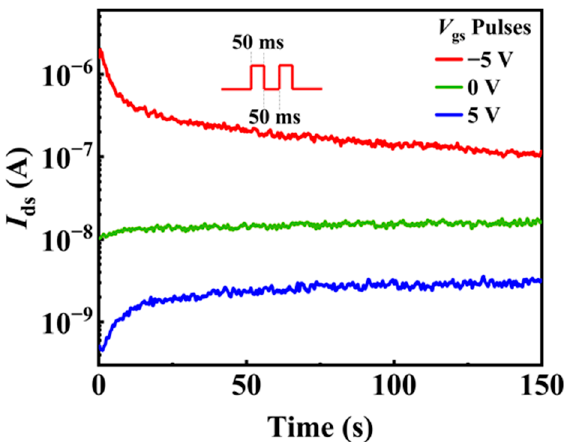
Figure 9. The current I ds change with time in the P(VDF-TrFE)-coated InAs NW device without applying gate voltage pulsed (green line), after applying 10 negative gate voltage pulses (red line) and after applying 10 positive gate voltage pulses (blue line). The duration time and interval time of the pulses are all 50 ms.